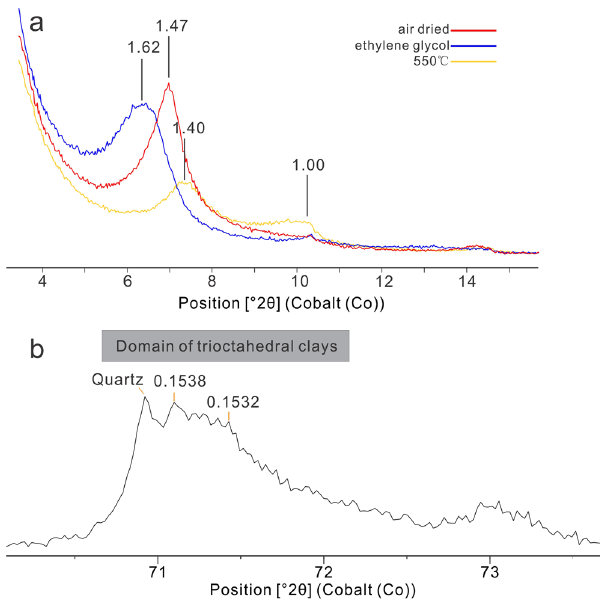
Fig. 3 Representative XRD patterns of the clay fraction (<2 µ m). a Qlk7, position of the 001 peak of oriented, Ca-saturated air-dried sample. b SX22, powder XRD pattern of the <2 µ m fraction showing the position of the 060 peak centered at ~1.53 nm, consistent with trioctahedral occupancy.